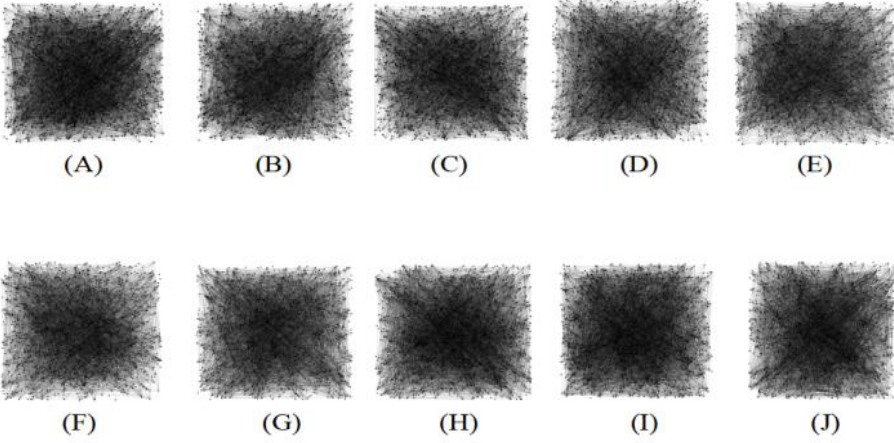
Figure 4. Corresponding graphs generated based on pixel-level graph construction. ( A – E ) represent head CT images with motion artifacts. ( F – J ) represent head CT images without artifacts.